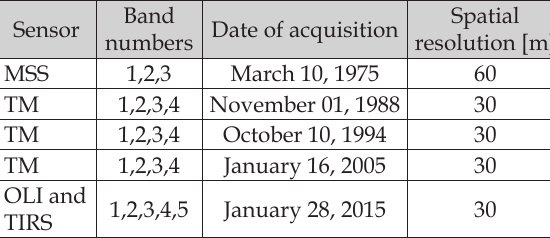
Table 1. Landsat satellite images utilized in the